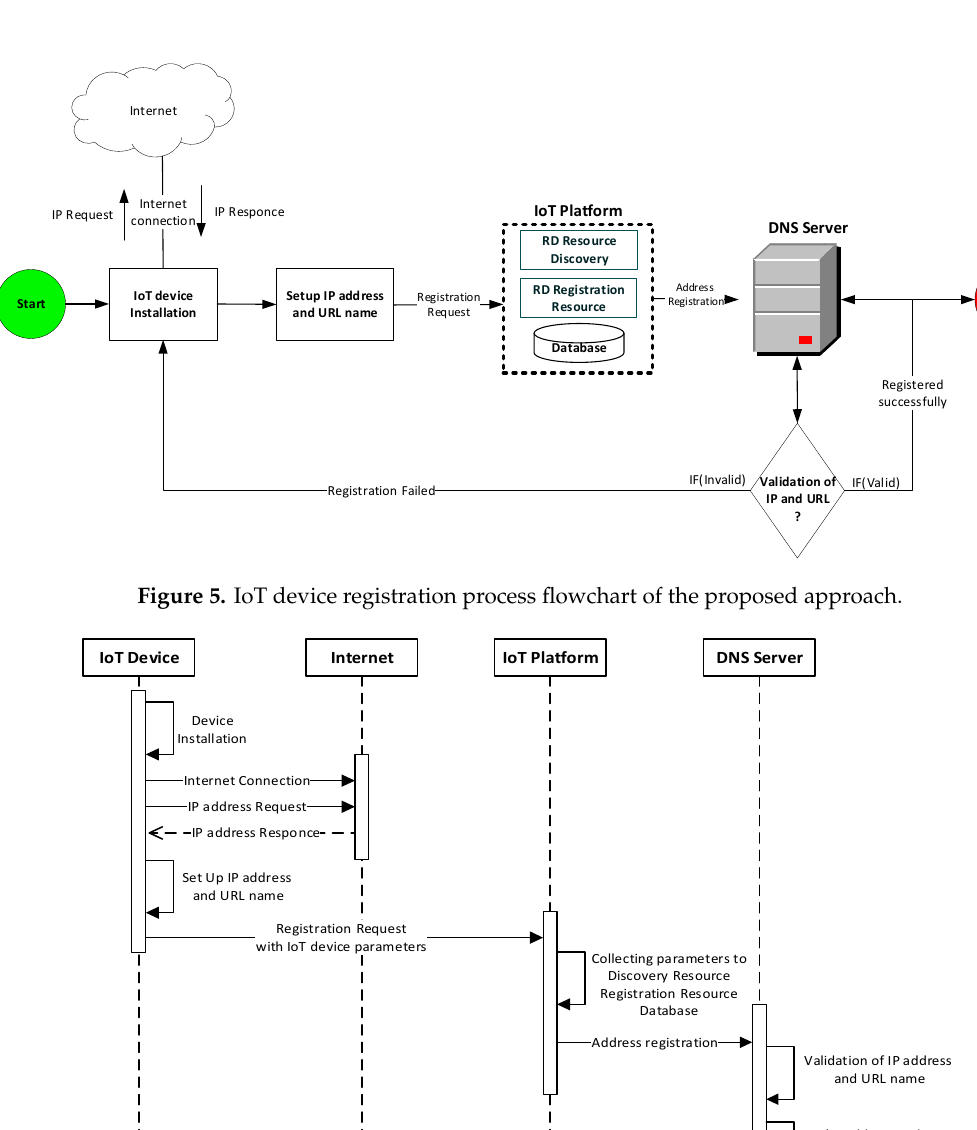
Figure 7. The general overview of the device discovery and sensing data process. Device and resource discovery are provided by CoAP endpoints. This function is critically essential in the M2M applications, in which there is no people’s role in the process, and there is a vulnerability due to static interfaces. CoRe Link Format provides resource discoverable services